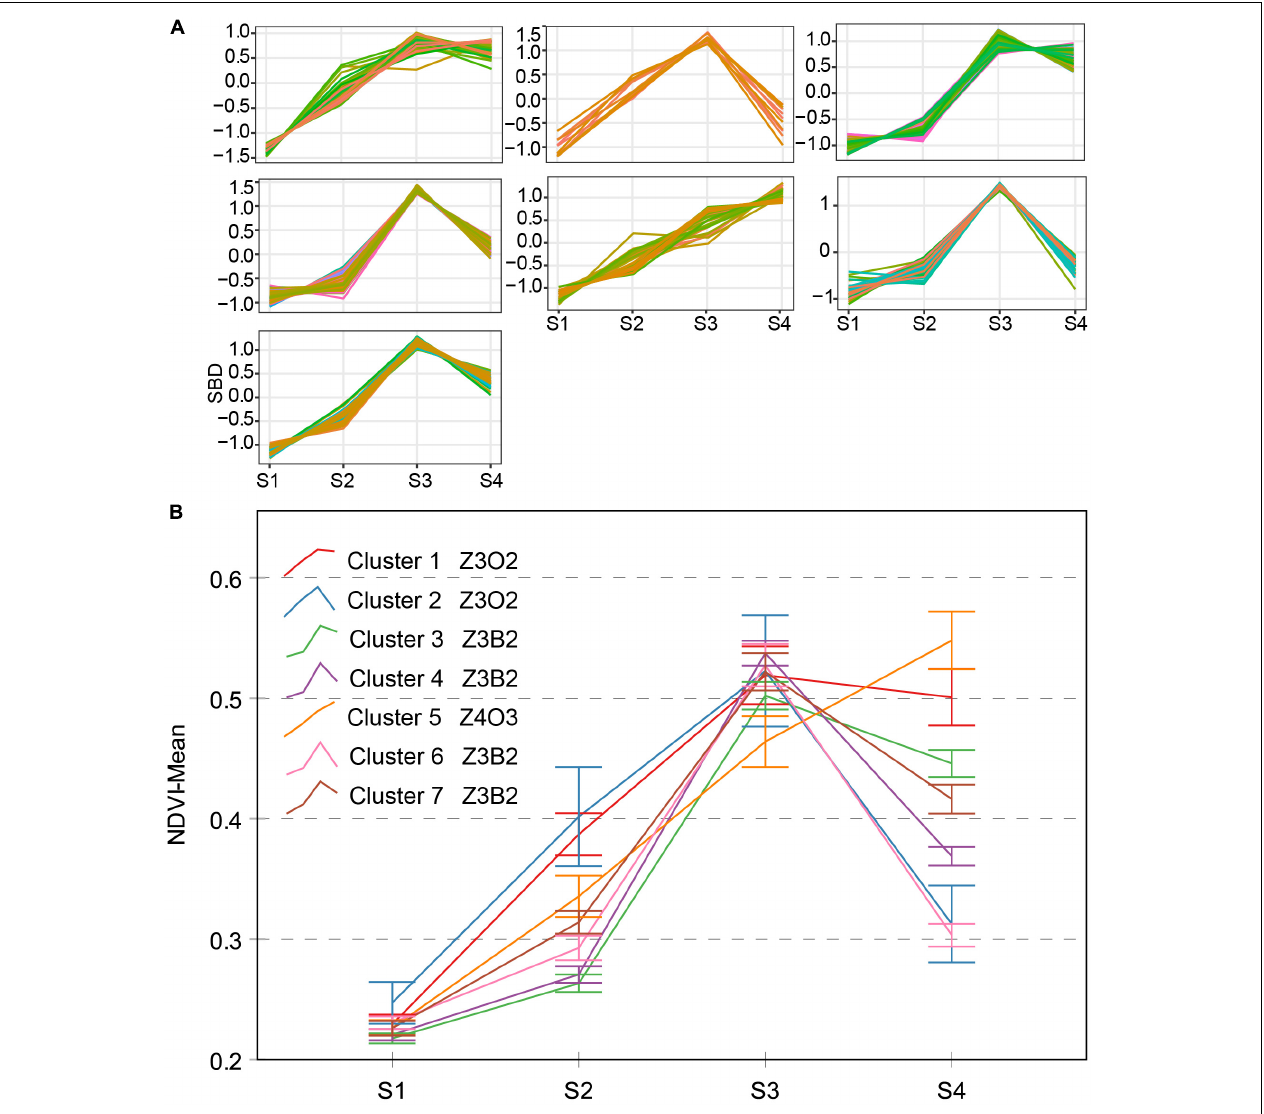
FIGURE 7 | Clustering analysis for NDVI time series (A) , seven clusters and typical curve of NDVI trait (B) . (A) The horizontal X -axis represents four growth stages, and the vertical Y -axis represents the shape-based distance. (B) The horizontal X -axis represents four growth stages, and the vertical Y -axis represents the mean value of NDVI at a specific growth stage. Zenith point all lies at the S3 growth stage and its adjacent point lies at the S2 growth stage except cluster 5. Typical curves are based on mean values with a 95% confidence interval. NDVI, normalized difference vegetation index; SBD, shape-based